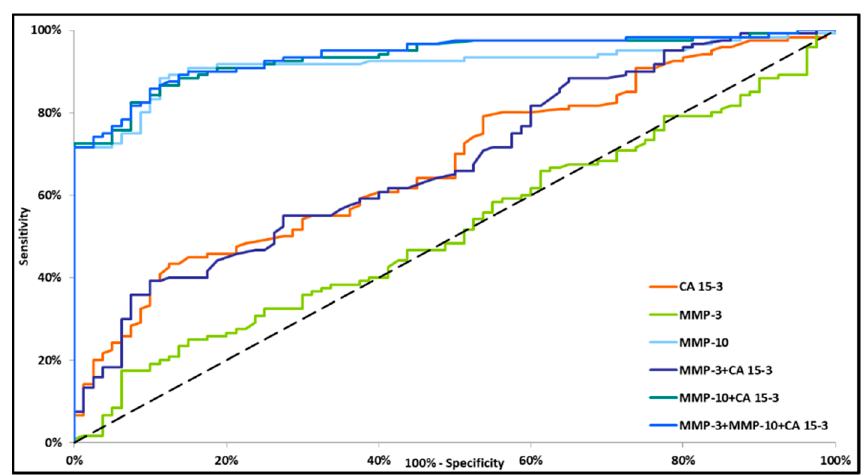
Figure 1. Diagnostic criteria of the ROC curve in total BC group. CA 15-3 – cancer antigen 15-3; MMP-3 – stromelysin-1; MMP-10 – stromelysin-2.